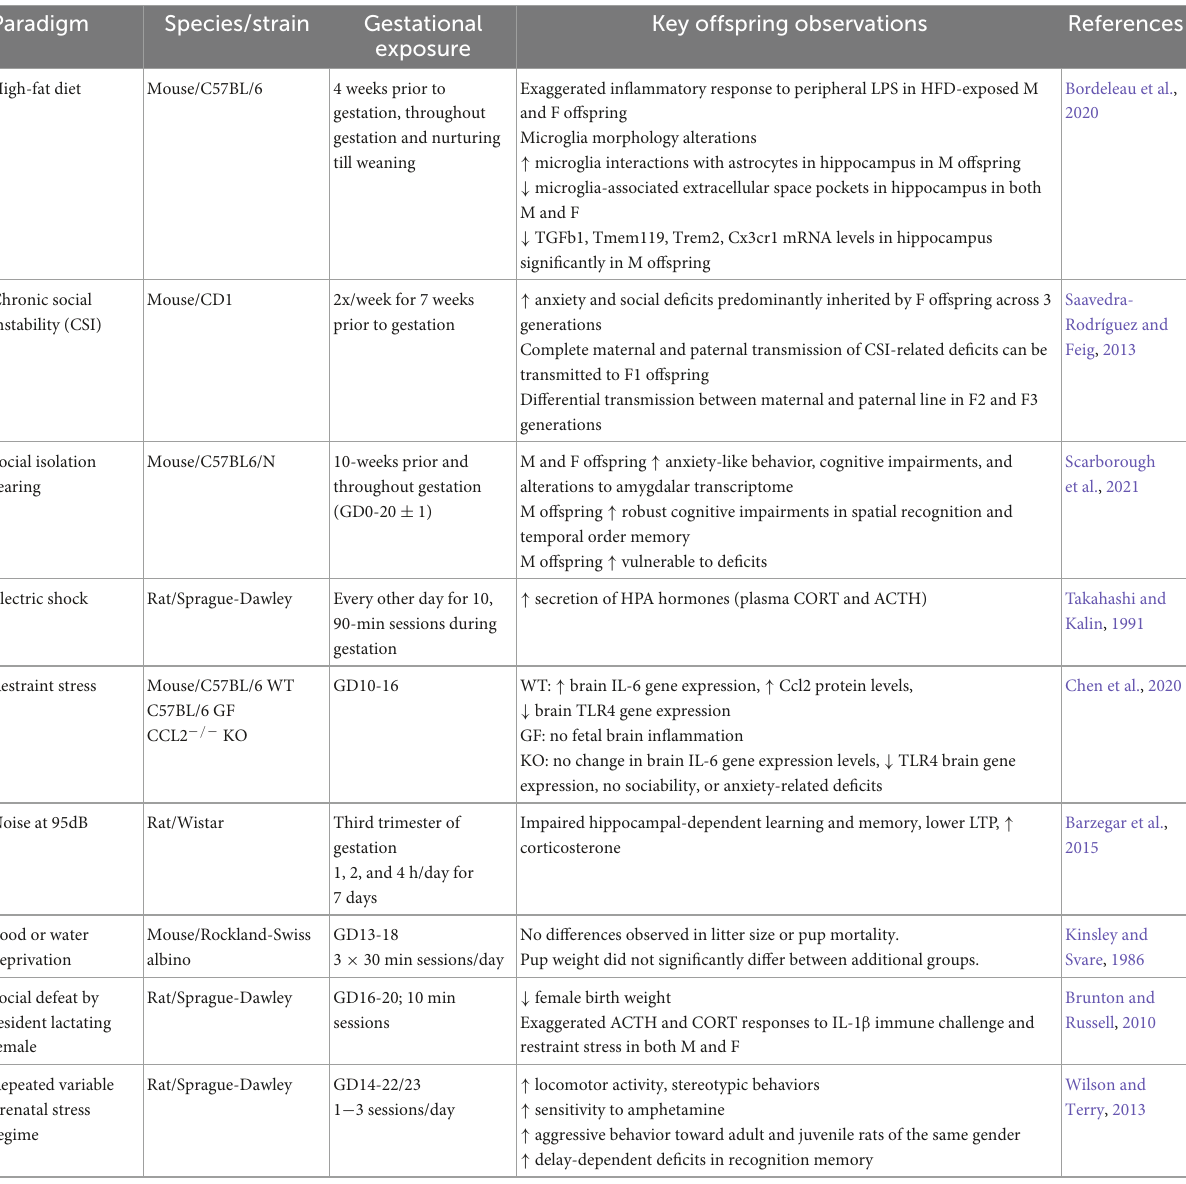
TABLE 2 Environmental-induced MIA offspring